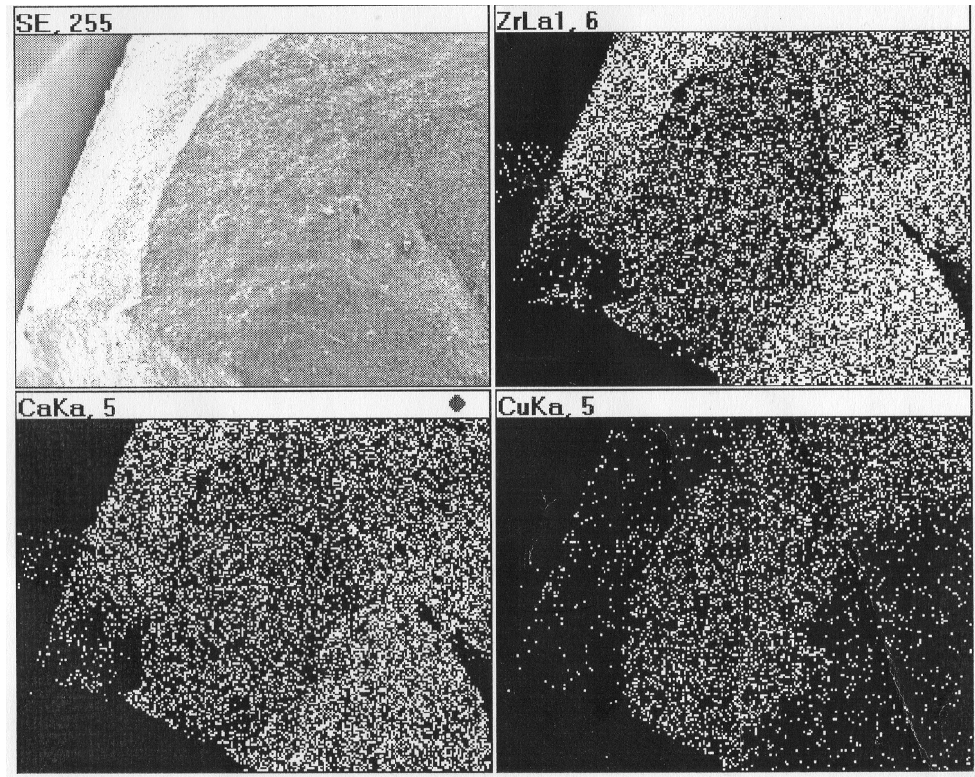
Figure 13. The surface of nostoichiometric CaZrO